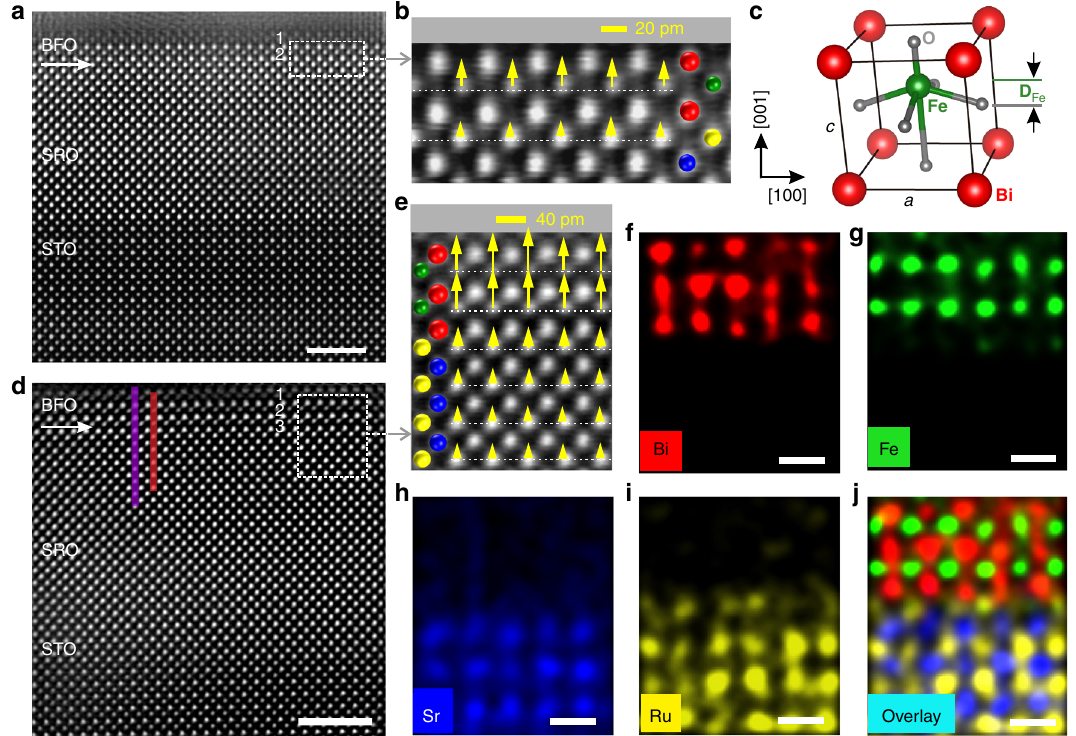
Fig. 1 Atomic-scale observation of polarization in 2- and 3-u.c. BFO. a Atomic-resolution HAADF-STEM image of 2-u.c. BFO. The scale bar is 2 nm. b Superposition of a magni fi ed image and B-site atomic displacement vector map from the area marked with a white dashed rectangle in a . c Schematic of the unit cell of ferroelectric BFO, D Fe denotes the relative displacement of the Fe atoms. d HAADF-STEM image of 3-u.c. BFO fi lm. The scale bar is 2 nm. e Superposition of a magni fi ed image and B-site atomic displacement vector map from the area marked with a white dashed rectangle in d . In the insets of b , e , yellow arrows represent the displacement vectors of B-site atoms and white dashed lines are drawn to guide visually. The length and direction of the arrows represent the magnitude and direction of the displacement vectors concerning the scale bar in the upper right corner, respectively. f – j The false- color Bi, Fe, Sr, Ru, and overlaid EDX elemental maps of e , respectively. The scale bar is 0.5